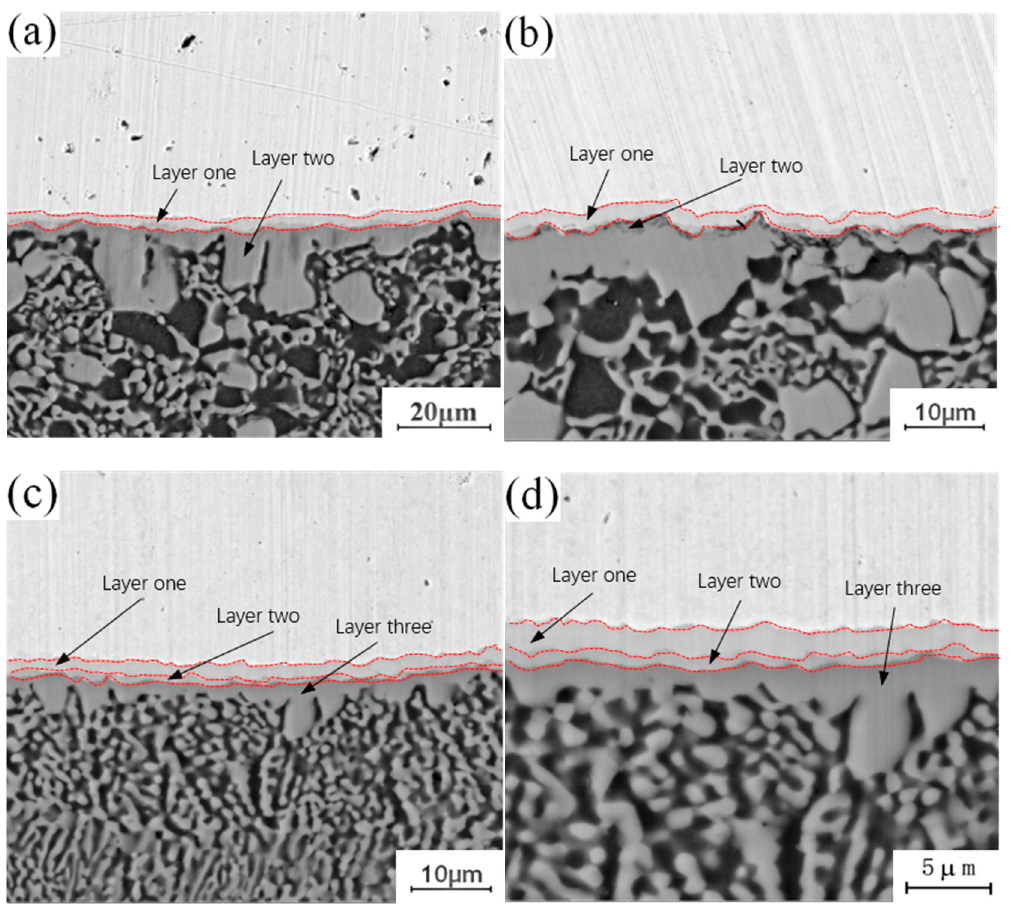
Figure 4. Microstructure of the intermetallic compound (IMC) layer annealed at 300 °C for different holding times: ( a ) t = 0.5 h; ( b ) t = 1.5 h; ( c ) t = 3.5 h; ( d ) t = 4.5 h.